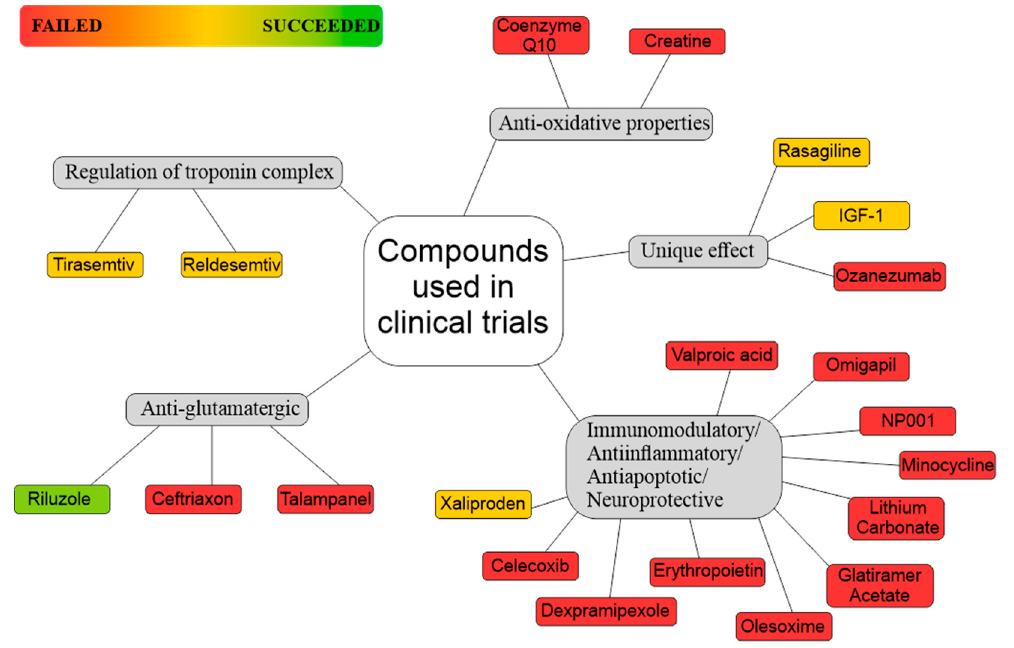
Figure 3. Compounds were divided into groups according to their e ff ect, as described in clinical studies. In the category of anti-glutamatergic both Ceftriaxone [286] and Talampanel [287] failed. Another category of drugs are compounds that are thought to have anti-oxidative properties. Both Coenzyme Q10 [288,289] and Creatine [290–294] have failed to demonstrate clinical e ffi cacy. Tirasemtiv and Reldesemtiv are able to regulate the release of calcium from the regulatory troponin complex and thus sensitize the muscle to calcium. Several trials assessed the e ffi cacy of Tirasemtiv in human ALS patients. From all the studies [295–298], only one [298] managed to show statistical significance on two out of five secondary endpoints. Based on the results, a large-scale follow up study was launched but failed to demonstrate e ffi cacy in all of its endpoints [299]. E ffi cacy of Reldesemtiv was assessed in a single Phase II trial. Although, this trial failed in its primary endpoint for all dose groups, patients showed a non-significant 27% reduction of decline in SVC. Moreover, all groups compared to the placebo, showed a significant 25% change in ALSFRS-R slope [300]. Most compounds used, are believed to have either immunomodulatory / anti-inflammatory / antiapoptotic and / or neuroprotective properties. Most of these compounds failed to demonstrate statistical significance in all of the studies´